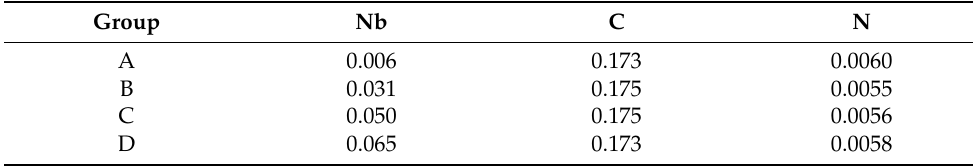
Table 3. The mass fraction of Nb, C, and N in the sample (wt%). Group Nb